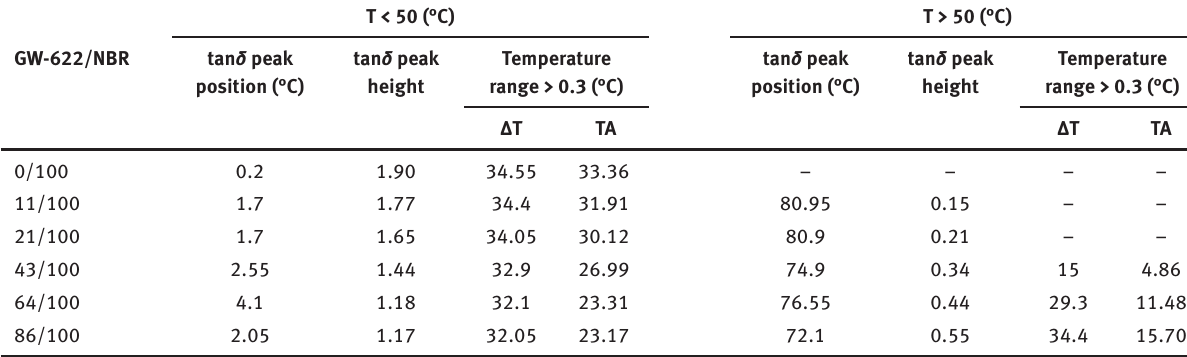
Table 1: Damping properties of the GW-622/NBR composite with different GW-622 molecule contents. T < 50 (°C)